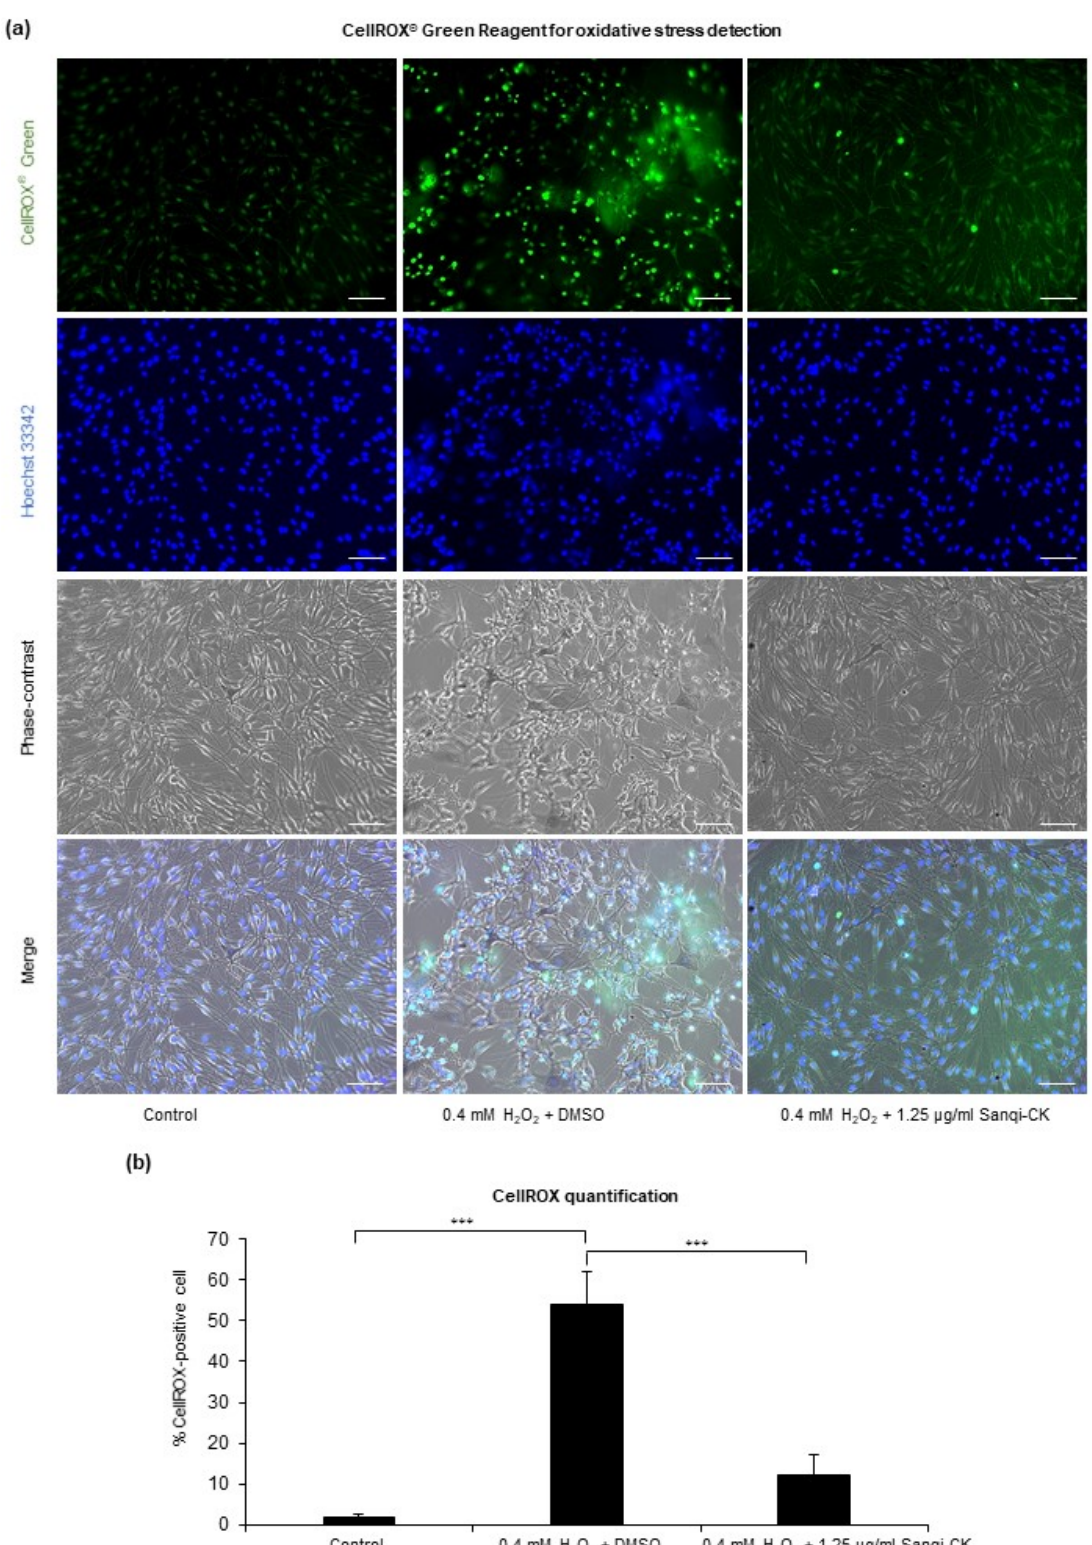
Figure 4. Effects of Sanqi-CK on oxidative stress in cultured human epidermal melanocytes (HEMn-MPs). The cells were pretreated with a nontoxic concentration of Sanqi-CK (1.25 μ g/mL) for 6 h, followed by 0.4 mM H 2 O 2 treatment for an additional 24 h. Oxidative stress in cultured cells was detected by CellROX ® Green reagent after exposure to the indicated treatments for 24 h. Nuclei were stained blue by Hoechst 33342. The cultured cells were photographed by phase-contrast and confocal fluorescence microscopy ( a ). Representative images obtained in three independent experiments are shown.